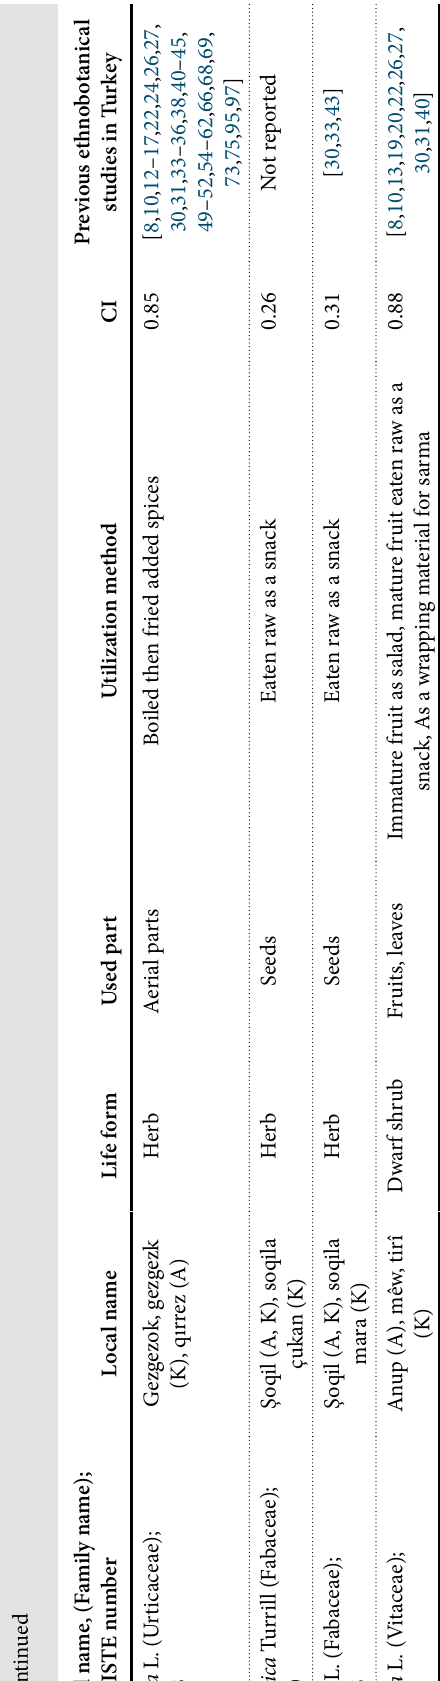
The corms of Crocus cancellatus subsp. damascenus and C. pallasii subsp. turcicus are collected during the mid to end of April. Their fibrous tunics are peeled off and the internal fleshy parts are eaten directly. Similarly, tubers of Scorzonera incisa and S. pseudolanata are collected from the end of March to mid-April and consumed raw after the skins are peeled off.